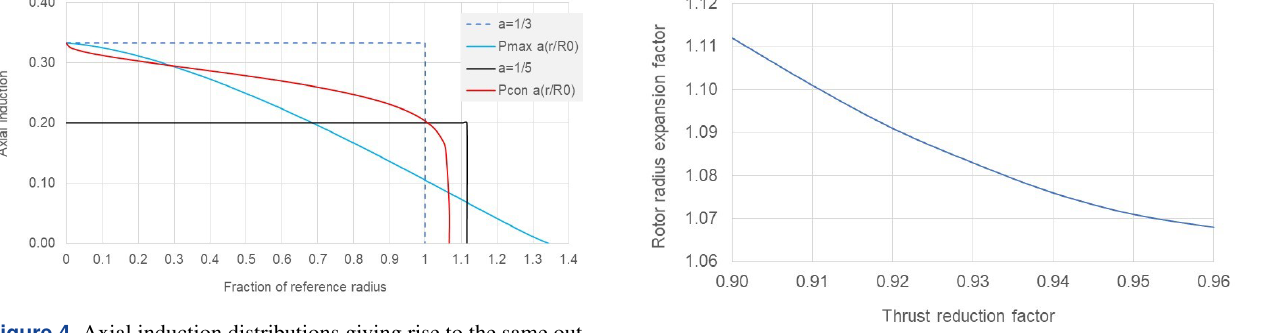
Figure 6. Rotor expansion related to thrust reduction for a fixed power gain (7.6%).